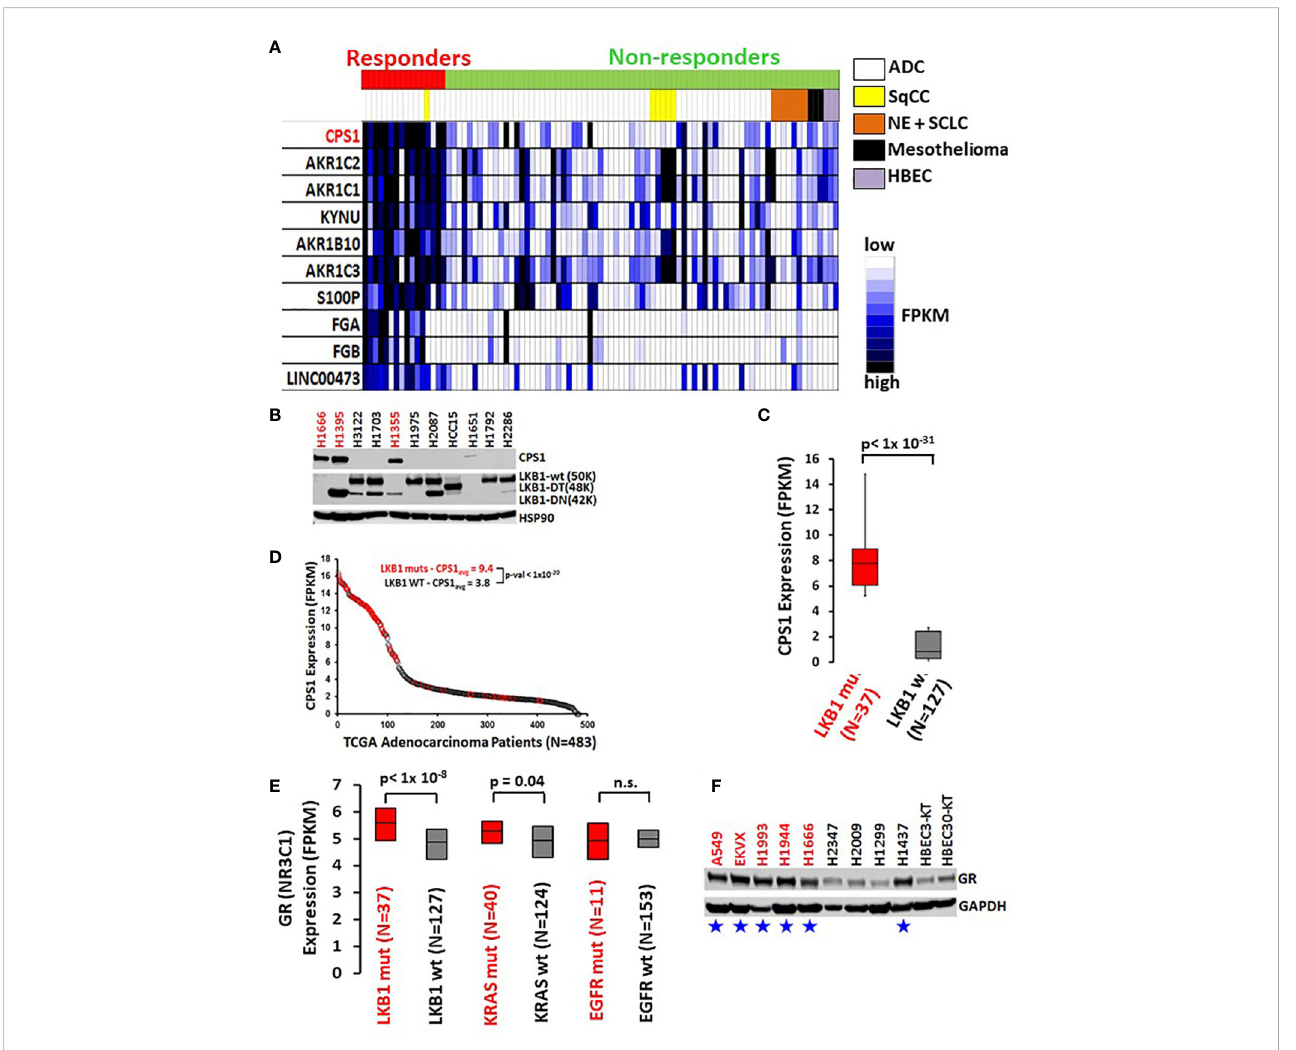
FIGURE 2 High CPS1 expression is the biomarker for DEX sensitivity and LKB1 mutation in lung cancer cell lines. (A) RNA expression heatmap of cell lines from NR ligand screen. CPS1 (red) was the most highly expressed gene in the DEX sensitive cell lines when compared to DEX resistant cell lines (p < 9.0 x 10 -16 ). (B) Exemplar western blot demonstrating the inverse correlation between the presence of LKB1 WT protein (50KDa) and the expression of CPS1 in lung cancer cell line panel. (C) Box and whisker plot of RNAseq analysis demonstrating strong association (p< 1x 10 -31 ) of high CPS1 expression with LKB1 mutation in large panel of NSCLC cell lines (N=164) (D) Analysis of TCGA transcriptome and mutation data demonstrate LKB1 loss is strongly associated with high CPS1 expression. (E) Box and whisker plot of RNAseq data from 164 NSCLC cell lines showing strong correlation between LKB1 loss and increased GR expression (p < 1x10 -8 ) and no correlation between GR expression and either KRAS or EGFR mutation. (F) Exemplar western blot con fi rms GR protein is more highly expressed in LKB1 mutants than wild type. Blue stars mark LKB1 mutant cell lines and red font indicates DEX sensitive cell